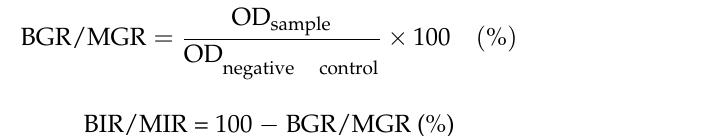
( D ). Antimicrobial activity (expressed as BIR/MIR%) of the OS extract.